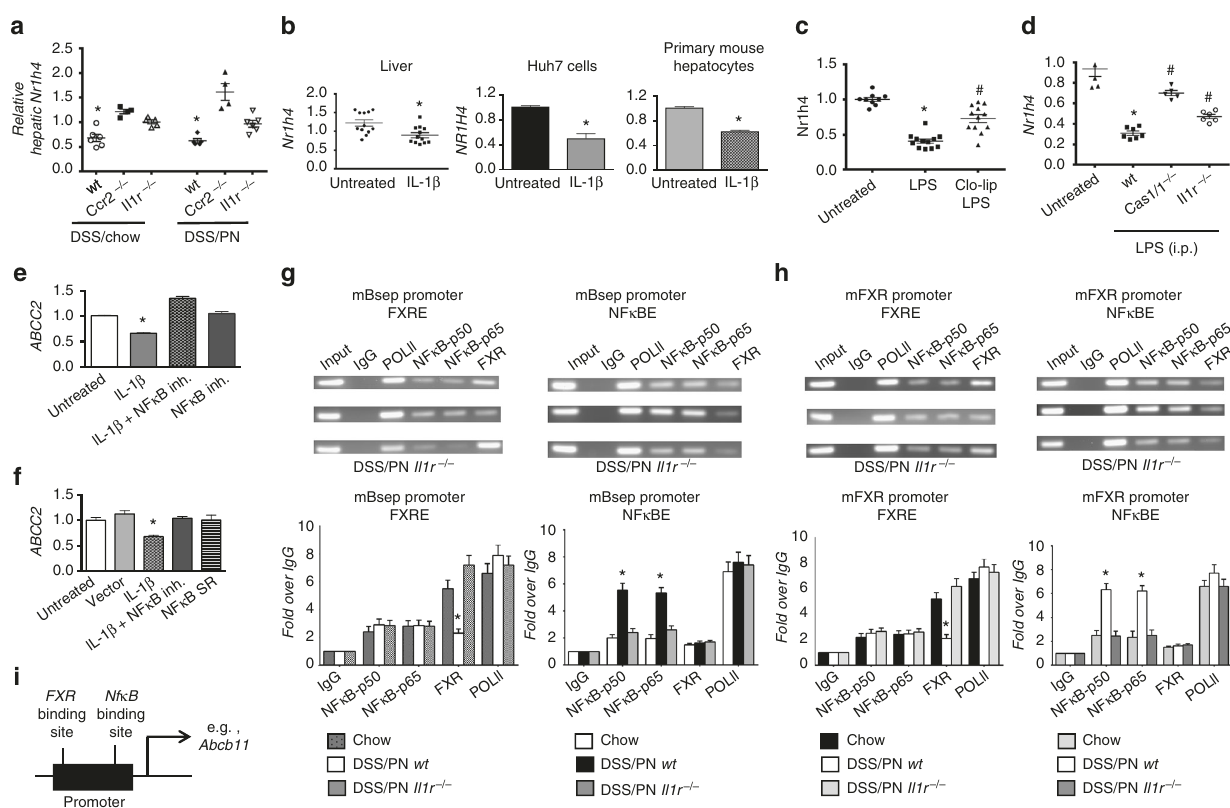
Fig. 4 IL-1 β -induced NF- κ B signaling suppresses FXR and ABCB11 . a Liver mRNA for Nr1h4 in WT, Ccr2 − / − , or Il1r − / − DSS/chow and DSS/PN mice. * p < 0.05 vs. all other groups. One-way ANOVA and Tukey's correction. b Relative mRNA expression of Nr1h4 in the liver of untreated and IL-1 β - exposed (i.p. for 4 h) mice and in HuH7 cells and primary mouse hepatocytes left untreated or exposed to IL-1 β for 4 h (depicting mean ± SEM of technical triplicates from one representative out of at least fi ve experiments). * p < 0.05 IL-1 β vs. untreated by t test. c , d Liver mRNA for Nr1h4 in untreated and LPS-exposed (2.5 mg/kg i.p. for 4 h) mice with and without prior i.p. treatment (16 h) with clodronate-liposomes (Clo-lip) and c relative to untreated and LPS exposed WT, Casp1/11 − / − , or Il1r − / − mice. * p < 0.05 vs. untreated and # p < 0.05 vs. LPS ( c ); * p < 0.05 vs. untreated and # p < 0.05 vs. wild type. e , f Relative mRNA expression of ABCC2 in HuH7 cells left untreated or exposed to IL-1 β (2 ng/ml) for 4 h with and without prior (1 h) exposure to NF- κ B inhibitor (BAY-11- 7082, 50 μ M; designated as NF- κ B in h ) with and without transient transfection with an NF- κ B repressor plasmid (NF- κ B SR) (depicting mean ± SEM of technical triplicates from one representative out of at least fi ve experiments). * p < 0.05 vs. all other groups by one-way ANOVA and Tukey's correction. g , h Chromatin immunoprecipitation (ChIP) on liver homogenate from WT chow, WT DSS/PN, and Il1r − / − DSS/PN mice with speci fi c antibodies for either FXR (left) or NF- κ B p50 and p65 subunits (right) binding to the promotor of mouse Abcb11 ( g ) or the promotor of mouse Nr1h4 ( h ) represented as semi- quantitative data (top) and quantitative PCR data with speci fi c primers (bottom). i Exemplary schematic depicting relative distance between binding